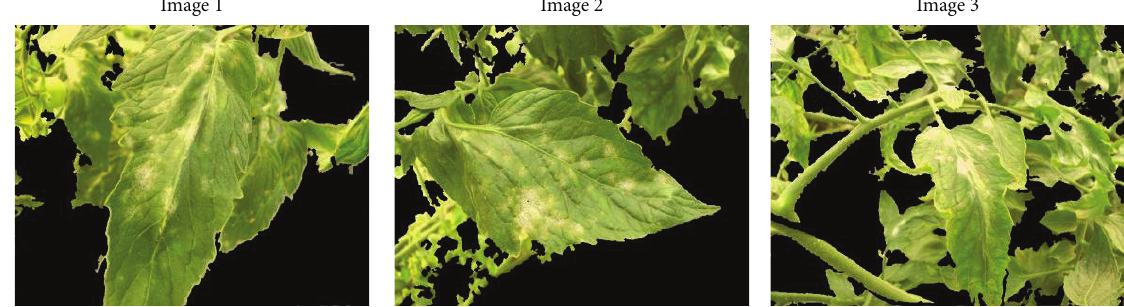
Figure 8: Example of resulting images after applying the process for recovering vegetation and disease areas incorrectly classified as nonvegetation.